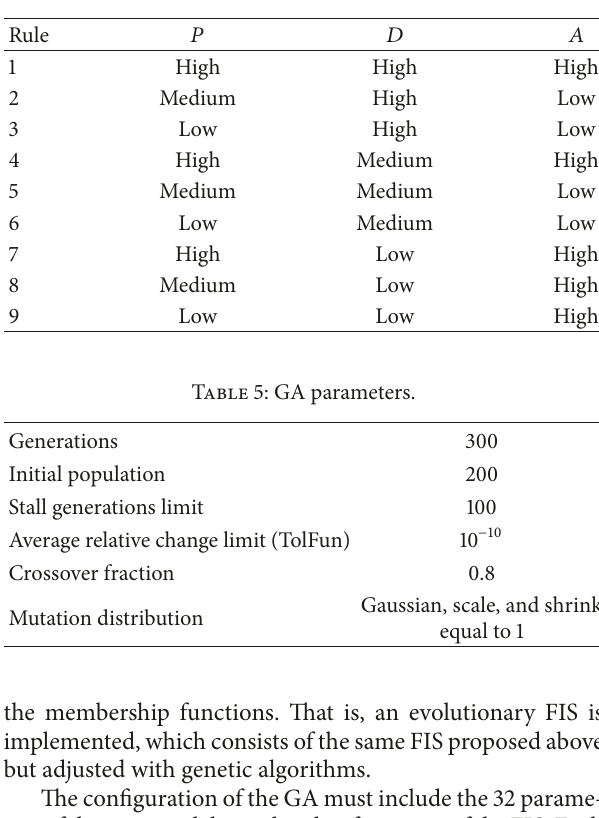
Table 4: Rules of the fuzzy approach.